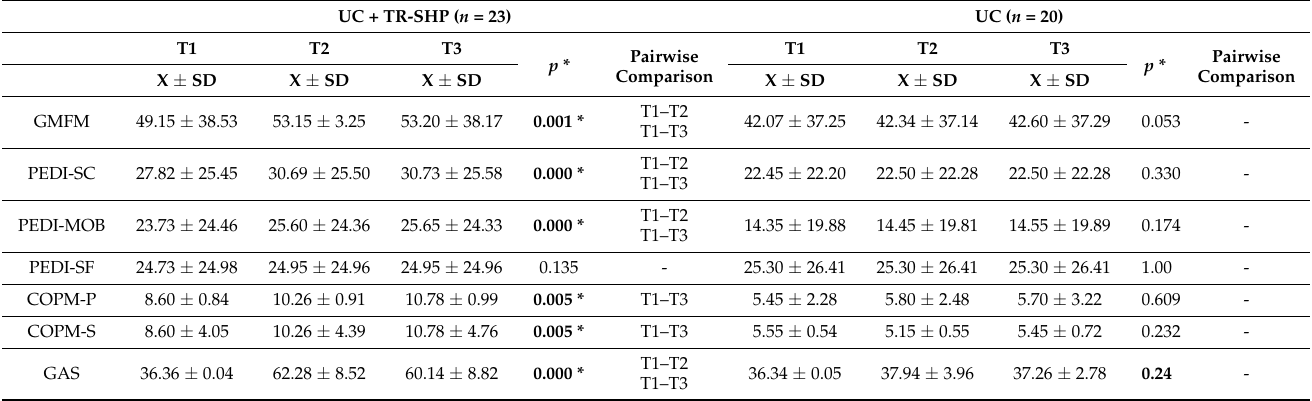
Table 4. Motor function, activity and participation change through time according to each